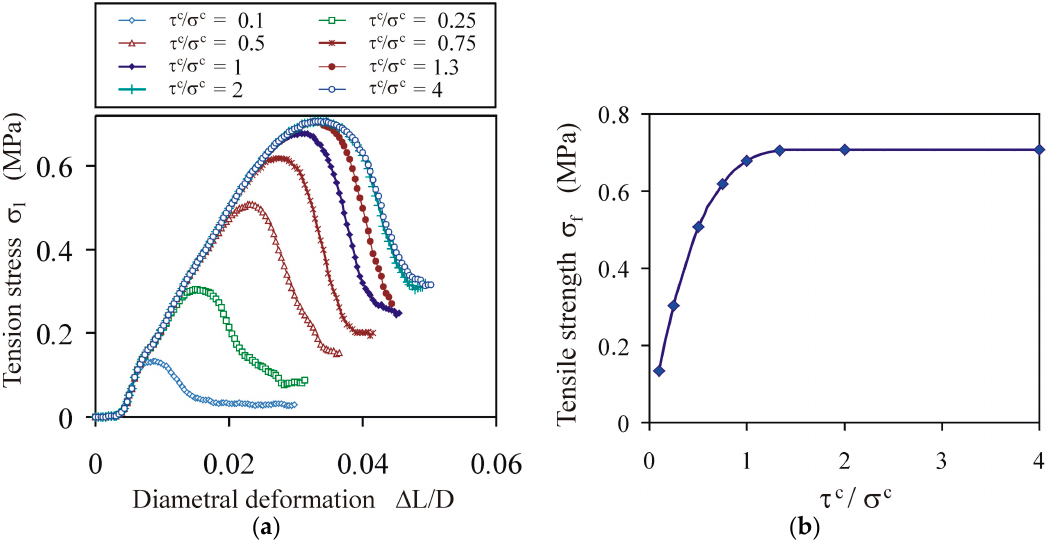
Figure 5. Effect of the τ c / σ c ratio on the tensile strength of agglomerates for σ c = 10 MPa and E b = 200 MPa: ( a ) tension stress vs. diametral deformation relationships σ 1 ( ∆ L / D ), and ( b ) tensile strength vs. bond shear strength-to-tensile strength relationship σ f ( τ c / σ c ).